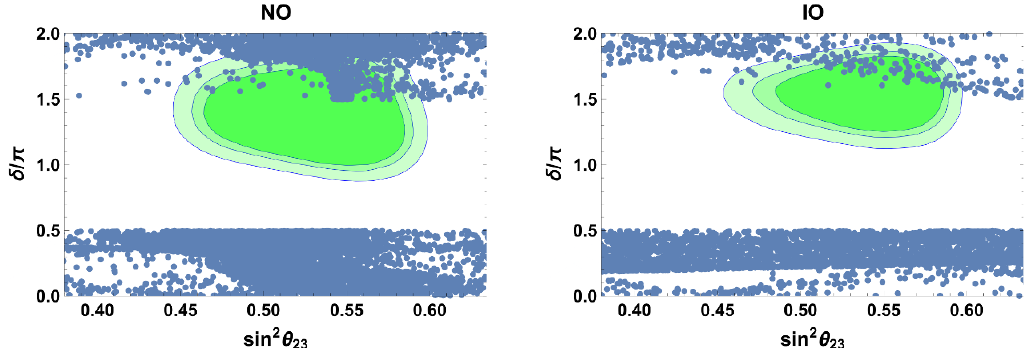
Figure 2 . Allowed values for the leptonic mixing parameters for Normal Ordering (NO) and Inverted Ordering (IO). All points lie within the 2 (cid:27) regions of the neutrino oscillation parameters. For comparison, the green regions correspond to the generic 90, 95 and 99% C.L. regions from the Global (cid:12)t in